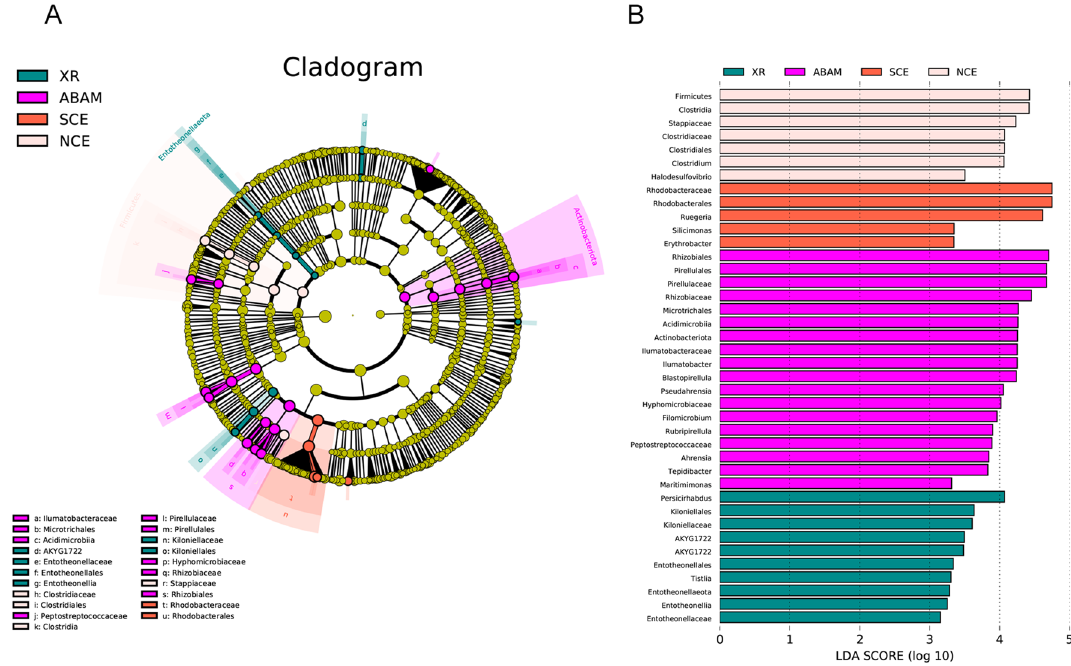
Figure 2. ( A ) Lefse clustering tree. Different colors represent different groups over the three seasons. The yellow nodes represent microbial taxa without significant differences among groups. Nodes with different colors represent the microbiota that plays an important role in the group represented by the color. A color circle represents a biomarker, and the legend in the upper right corner is the name of biomarker. From the inside to the outside, each circle is the taxa at the level of phylum, class, order, family, and genus. ( B ) Histogram showing the distribution of Least Discriminant Analysis